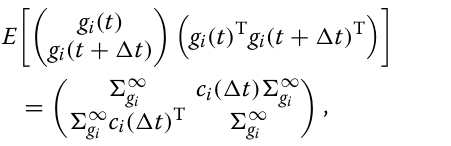
The second column corresponds to the coordinate system each field is expressed in. GEO stands for geographic, SM for solar magnetic, MAG for magnetic and GSM for geocentric solar magnetospheric. ℓ max is the maximum degree of the SH expansion, for the three following types of decomposition: standard with m = [− l , l ] , zonal with m = 0 and zonal iso where m = { 0,1, − 1